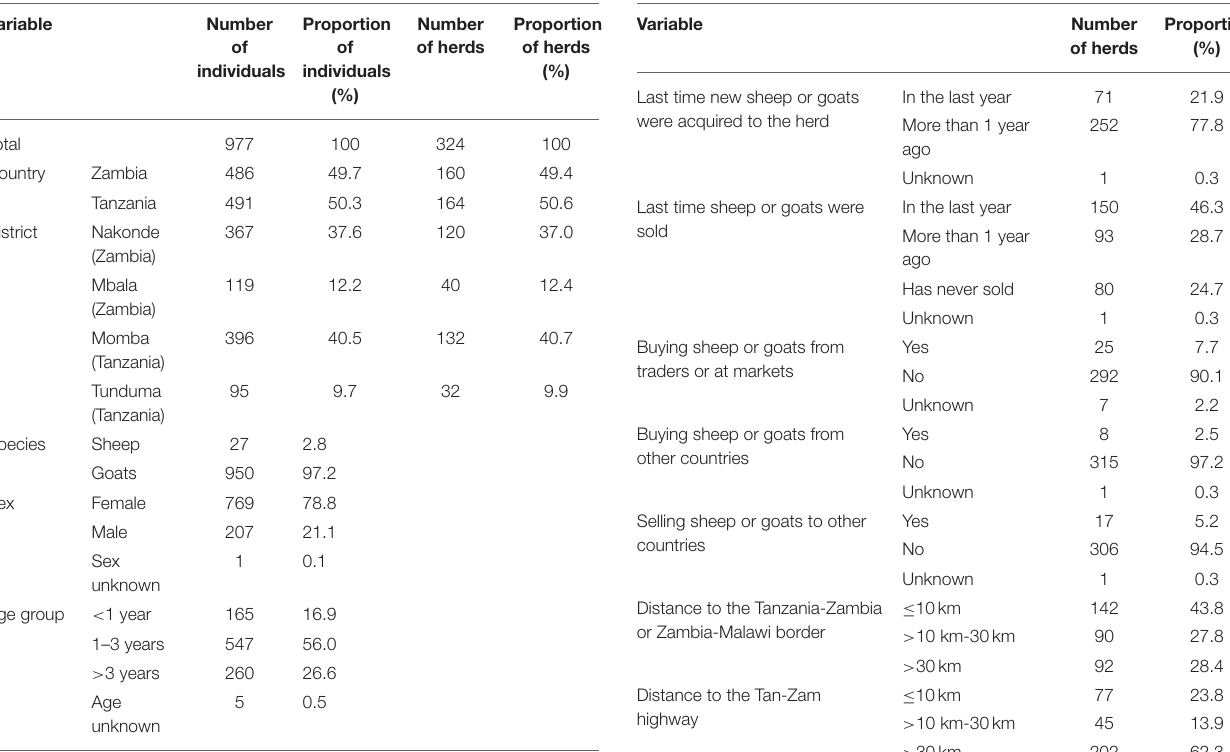
TABLE 2 | Trade routines and distances to the Tanzania-Zambia or Zambia-Malawi border, to a town and to the Tan-Zam highway. Proportion Number Proportion Variable Number of of herds of herds of individuals individuals (%)